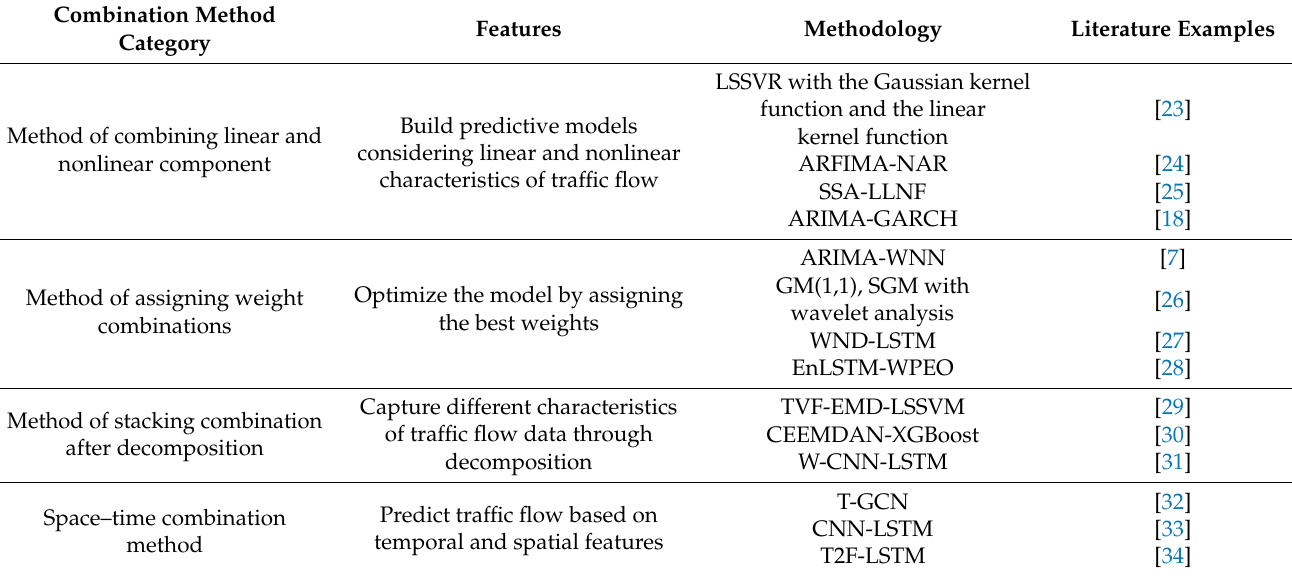
Table 1. Previous literature on combining